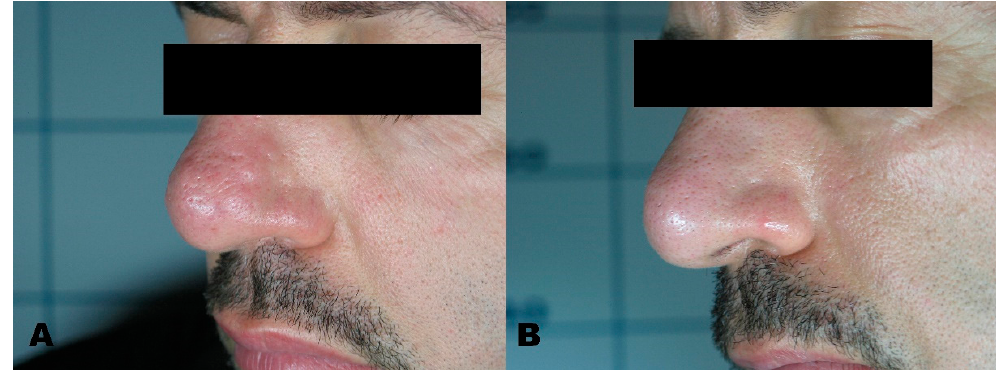
Figure 3. ( A ) Sebaceous hyperplasia before treatment. ( B ) Region after removal with Erbium laser.